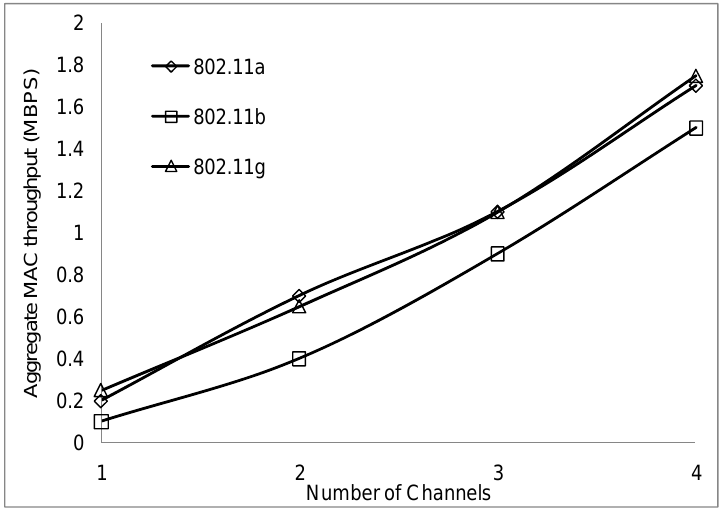
Figure 27. Aggregate throughput at 100 m range and data rate of 10 Mbps.